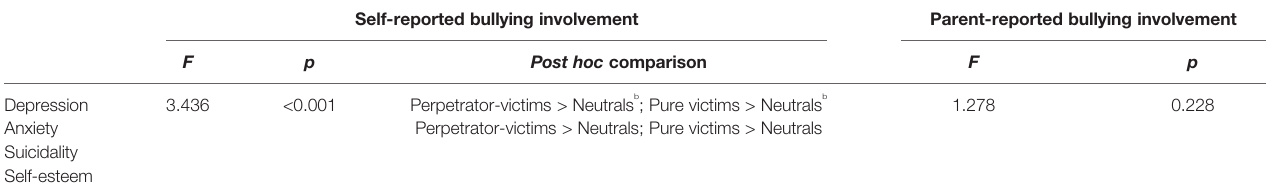
TABLE 4 | Comparisons of depression, anxiety, suicidality, and self-esteem among the groups of various self-reported and parent-reported bullying involvement: multivariate analysis of covariance a . Self-reported bullying involvement